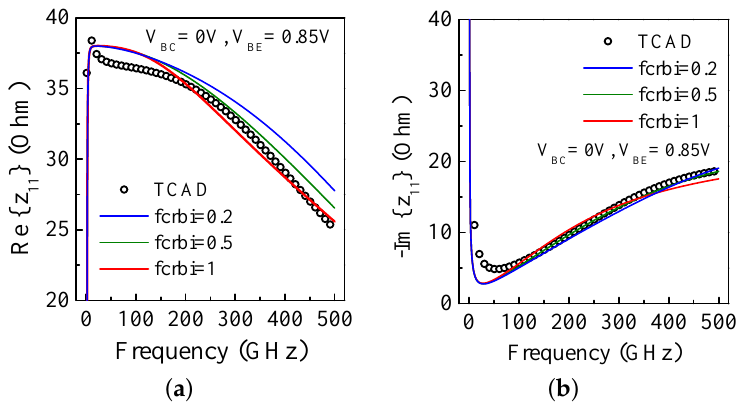
Figure 17. Sensitivity of fcrbi on frequency dependent (cid:60) z 11 ( a ) and (cid:61) z 11 ( b ) for the 0.09 µ m × 4.8 µ m SiGe HBT biased at V BC = 0 V with V BE = 0.85 V: comparison between TCAD (circles) and Hicum L2v2.4 (solid